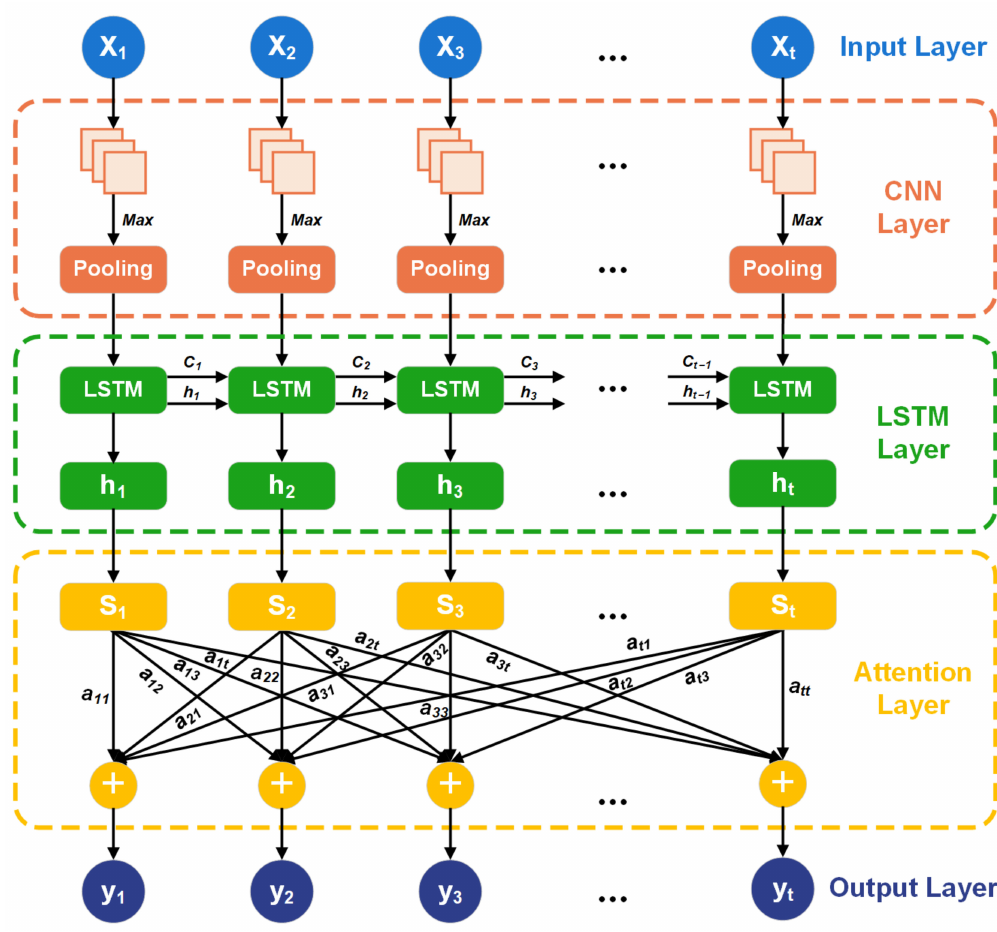
Figure 4. Framework of the proposed